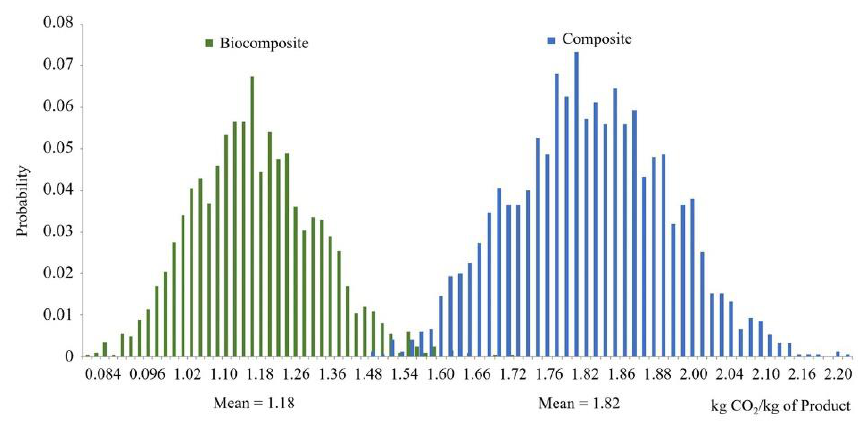
Figure 8. Probability distribution of Monte Carlo simulation results for global warming potential of biocomposite and petroleum-based composite, with 95% confidence interval.